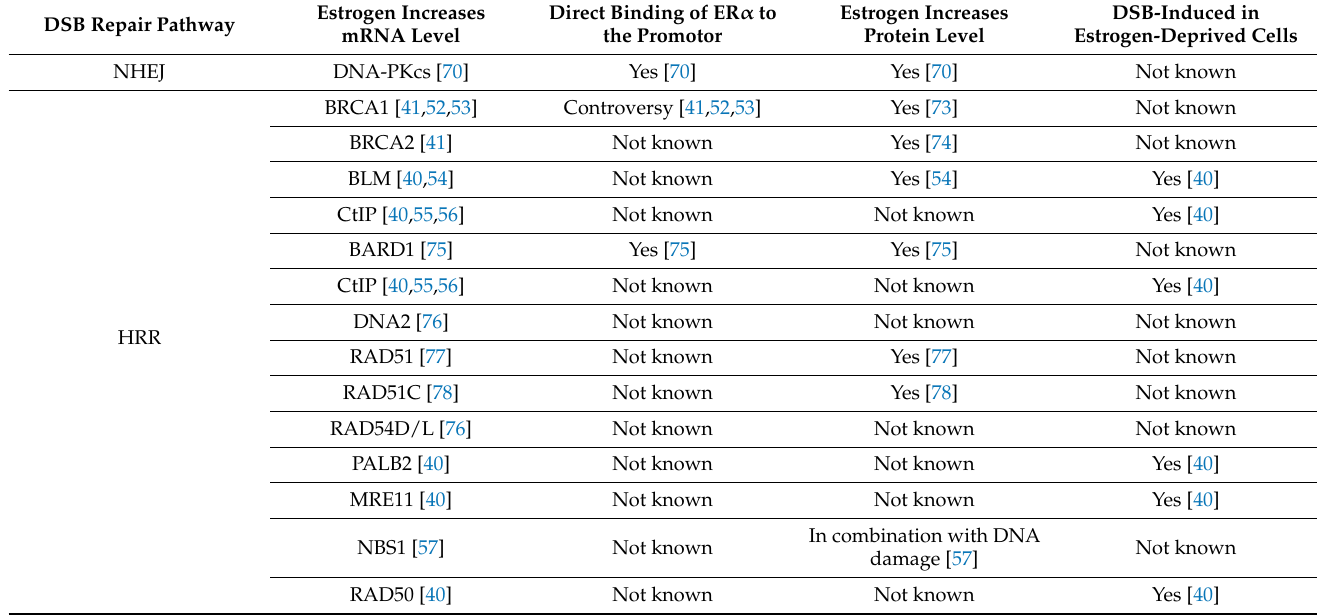
Table 1. A list of DSB repair genes that their mRNA levels are upregulated by